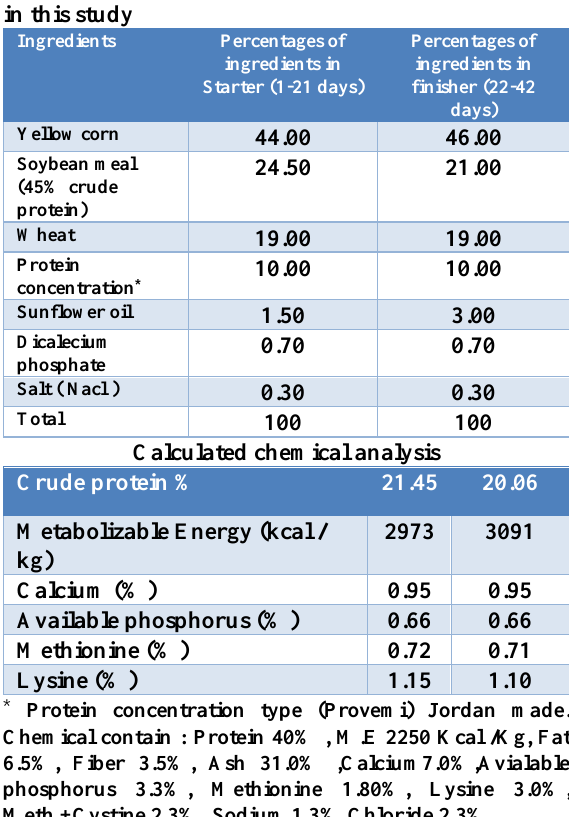
Table, 1: Composition of experimental diet